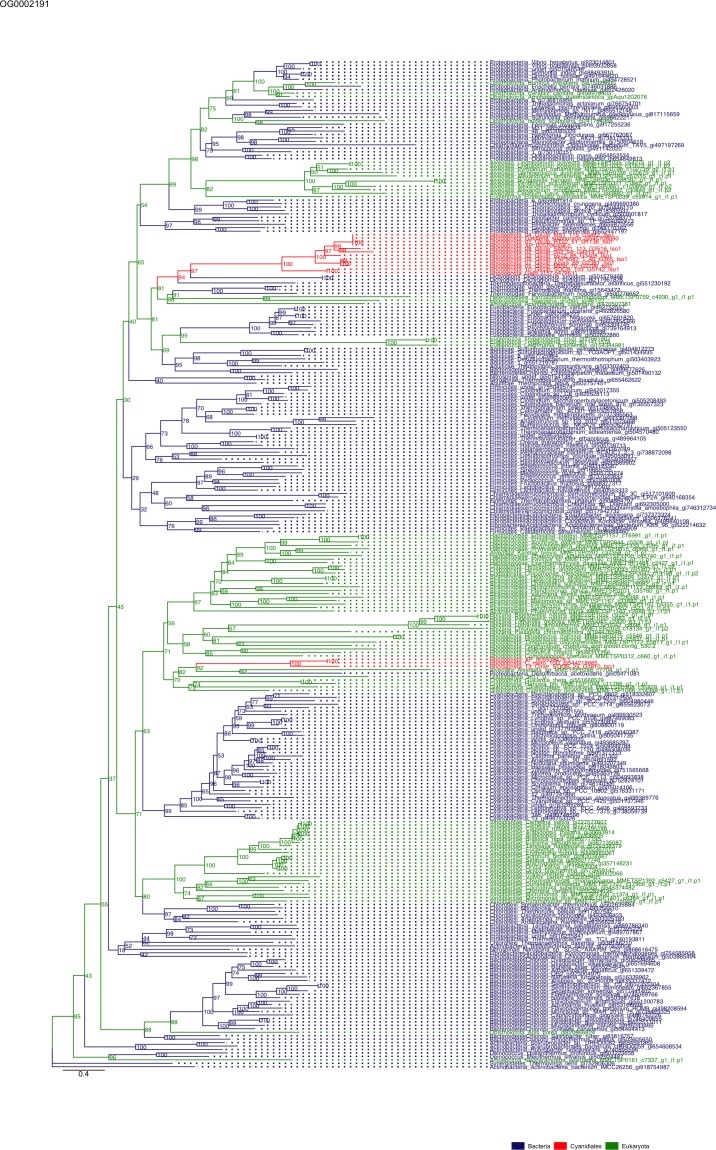
Sequence tree of orthogroup OG0002191.The tree is based on amino acid sequences. Archaea (yellow), Bacteria (blue), Cyanidiales (red), Eukaryotes including other red algae (green). Branches containing Cyanidiales sequences are highlited in red.